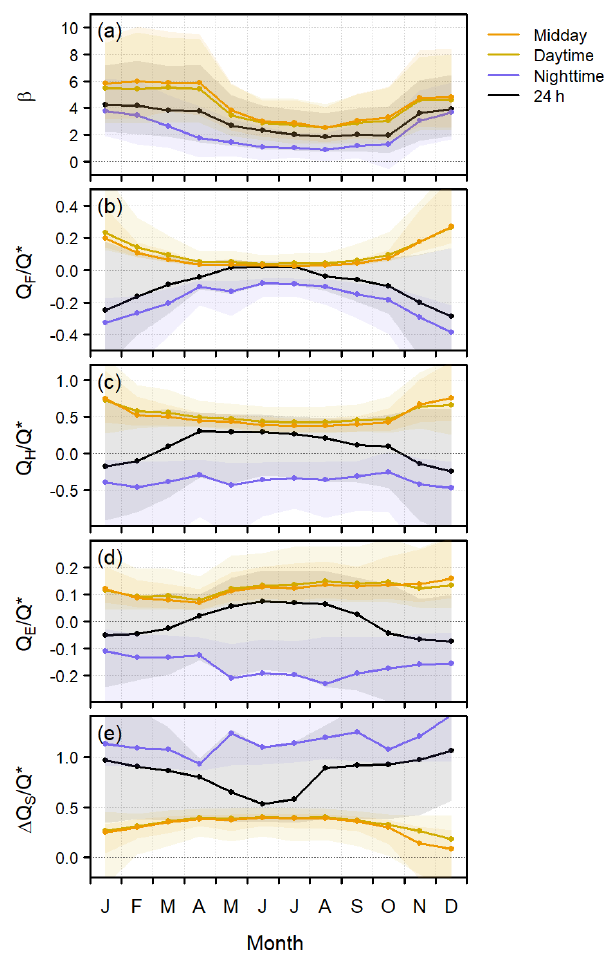
Figure 13. Energy partitioning at IAO for different subsets, with midday (11:00–15:00CET), daytime ( K ↓ > 5Wm − 2 ), nighttime ( K ↓ ≤ 5Wm − 2 ) and 24h. Lines indicate the monthly median val- ues and shading the interquartile range for (a) the Bowen ratio and for (b) the anthropogenic heat flux, (c) sensible heat flux, (d) la- tent heat flux and (e) net storage heat flux (calculated using OHM) normalised by net